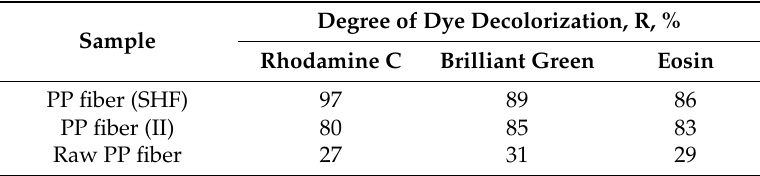
Table 7. The decolorization degree of water-soluble dyes with participation of composites